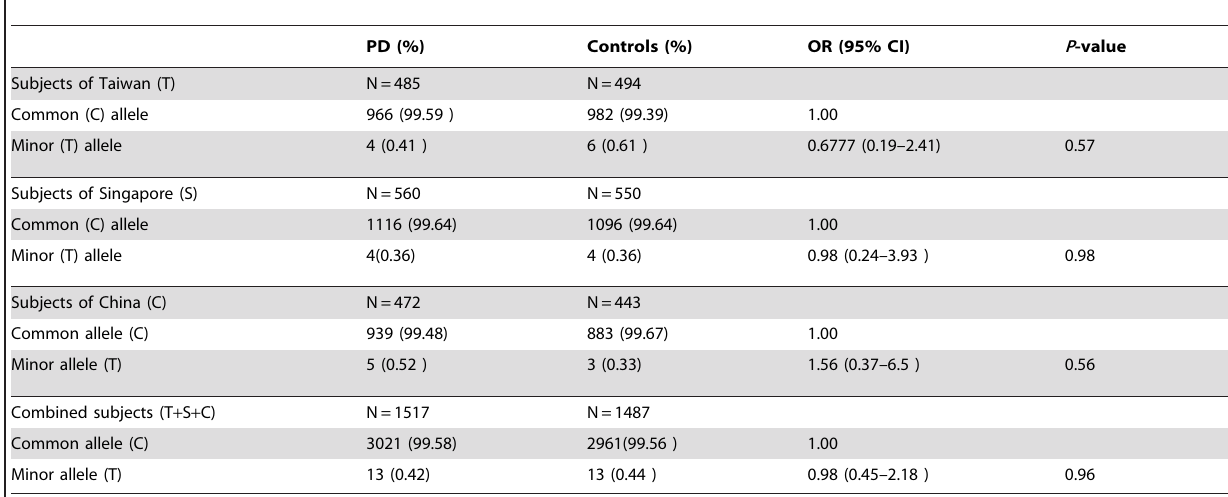
Table 1. Frequency of Allele Polymorphisms of LRRK2 rs34594498 among Parkinson’s Disease (PD) and Controls in Taiwan, Singapore and